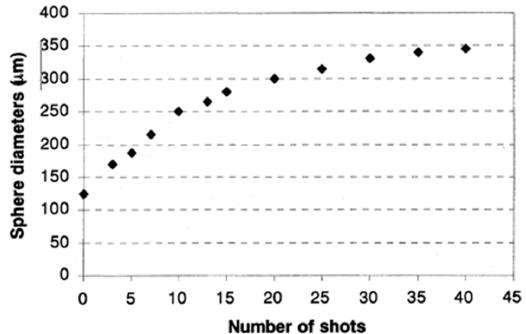
Figure 3. Size of the microspheres produced at the tip of a standard 125 μ m telecom fiber, as a function of the arc shots in a fiber fusion splicer. Reproduced from [15].